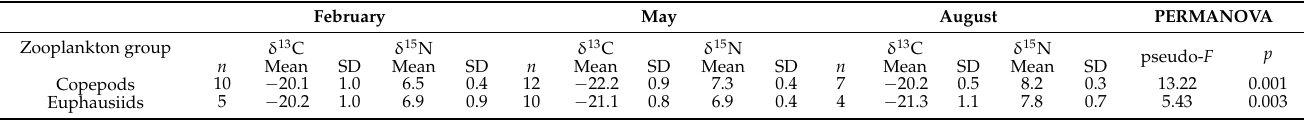
Table 1. Mean δ 13 C and δ 15 N values of the zooplankton groups calanoid copepods and euphausiids, collected during February, May, and August 2021 in the South Sea of Korea (#104, #106, #111, and #224). PERMANOVA test of δ 13 C and δ 15 N values for each zooplankton among seasons. Bold-faced font indicates significance at p < 0.05. Data represent means ± 1 SD.